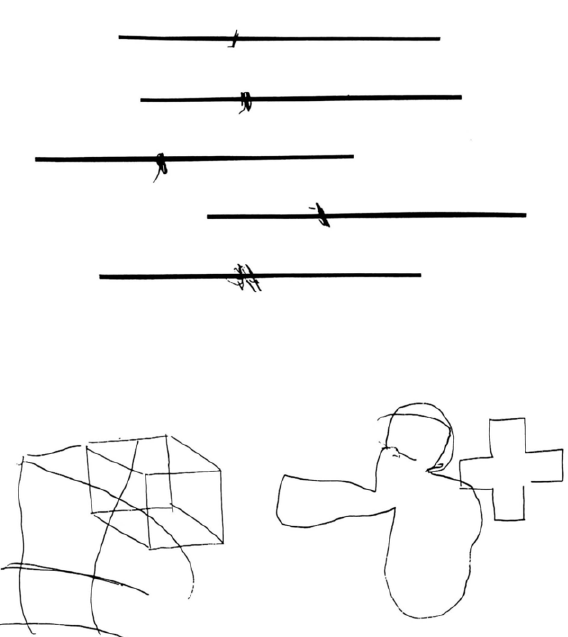
FIG 2. Line bisection and copying figures showed distinct right